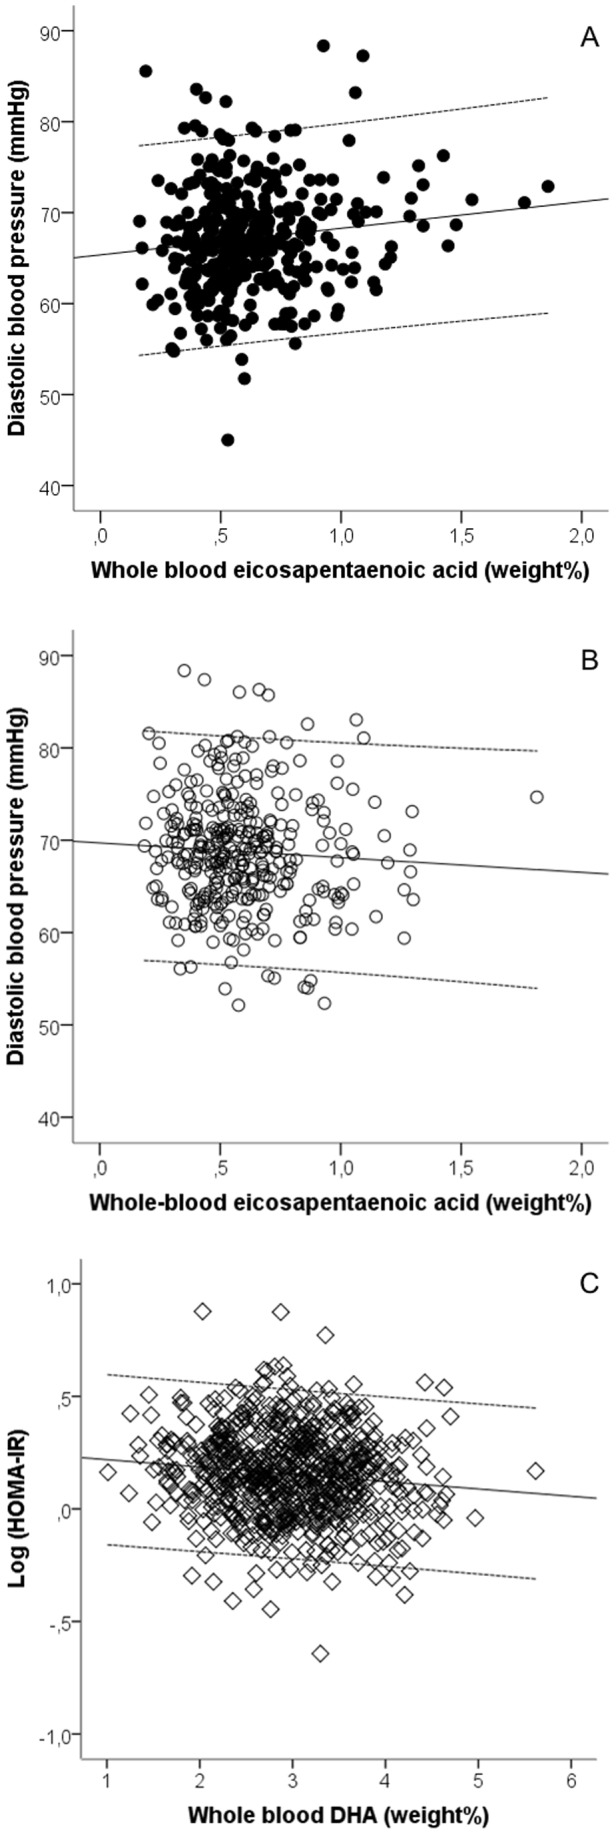
Whole blood eicosapentaenoic acid is sex-specifically associated with diastolic blood pressure whereas docosahexaenoic acid is negatively associated with HOMA-IR in all children.Regression lines and 95% CI are shown for the associations between eicosapentaenoic acid and diastolic blood pressure in boys, β = 2.9, P = 0.02, n = 366 (A) and girls, β = −1.6, P = 0.28, n = 340 (B) and for the association between docosahexaenoic acid and HOMA-IR in the total study population, β = −0.03, P = 0.002, n = 713 (C). Plots were adjusted for school, class, parental education, age, height, puberty, and total fatty acids in whole blood. Blood pressure plots were additionally adjusted for ambient temperature and blood pressure device.